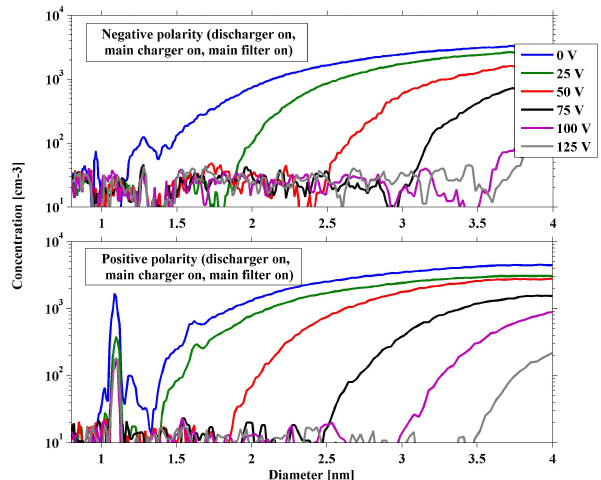
Fig. 8. Filtering of the charged particles with the electrical filter. The panels show the concentration of negative (top) and positive (bottom) corona ions and sample particles as a function of the volt- age applied to the main filter